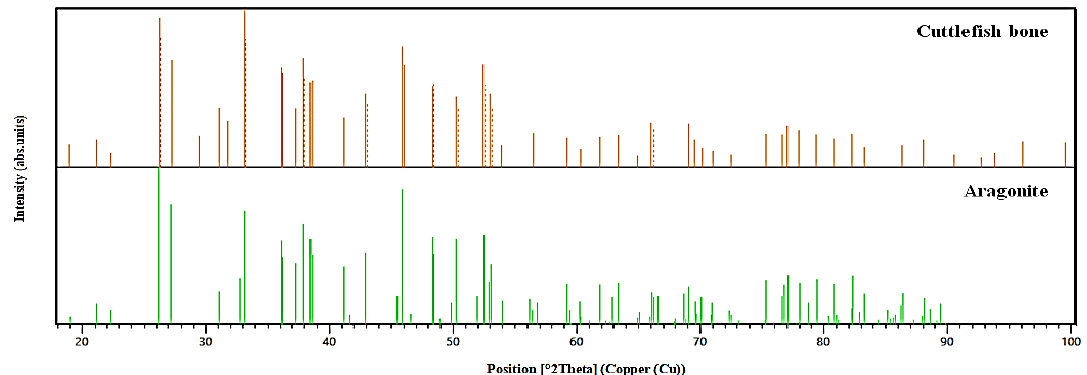
Figure 9. Comparison of XRD patterns of CB powder and aragonite.